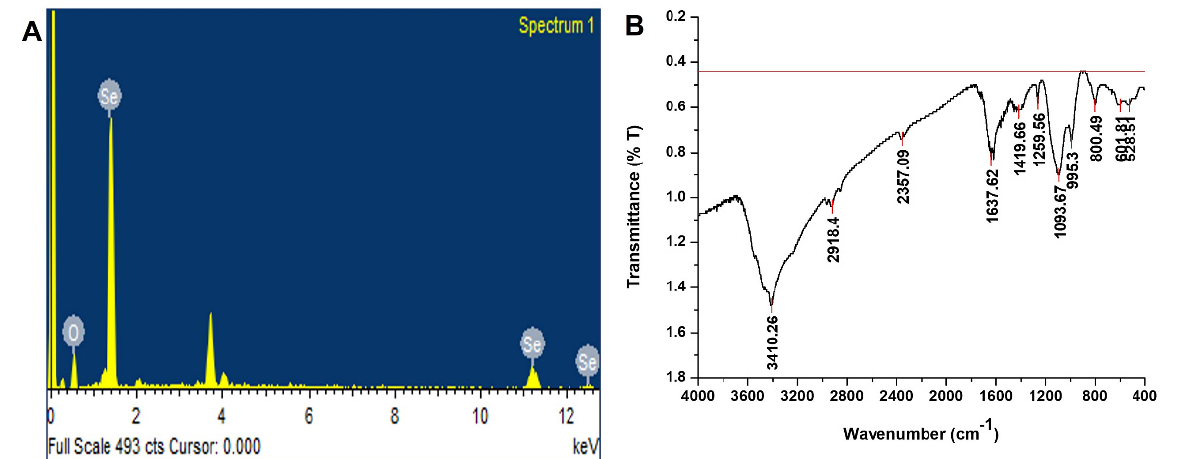
Figure 1. ( A )EDX Spectrum of SeNPs;( B ) FTIR spectrum of SeNPs. Figure 2. ( A ) EDX Spectrum of SeNPs;( B ) FTIR spectrum of